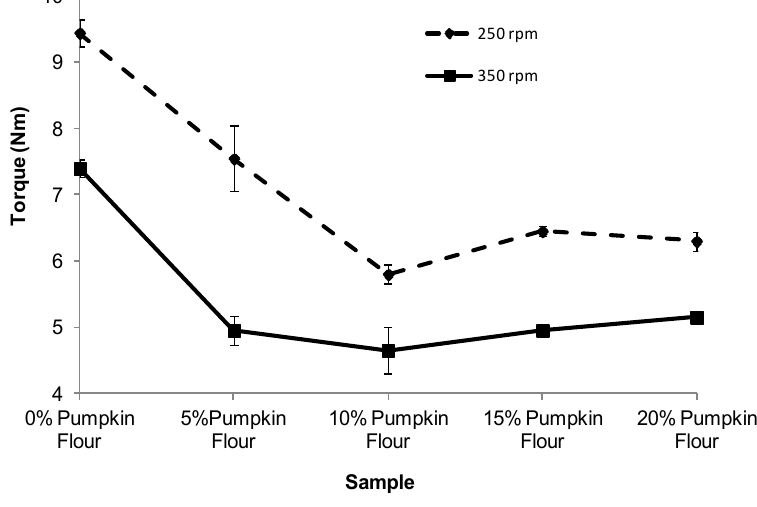
Figure 2. Effect of screw speed and the proportion of pumpkin flour on torque during